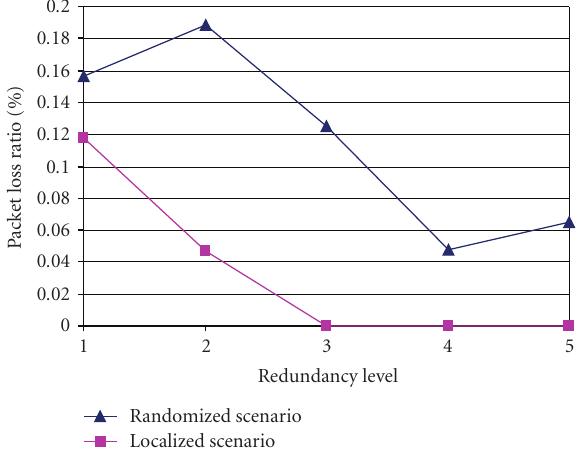
Figure 9: Packets Loss ratio—Heavily loaded.